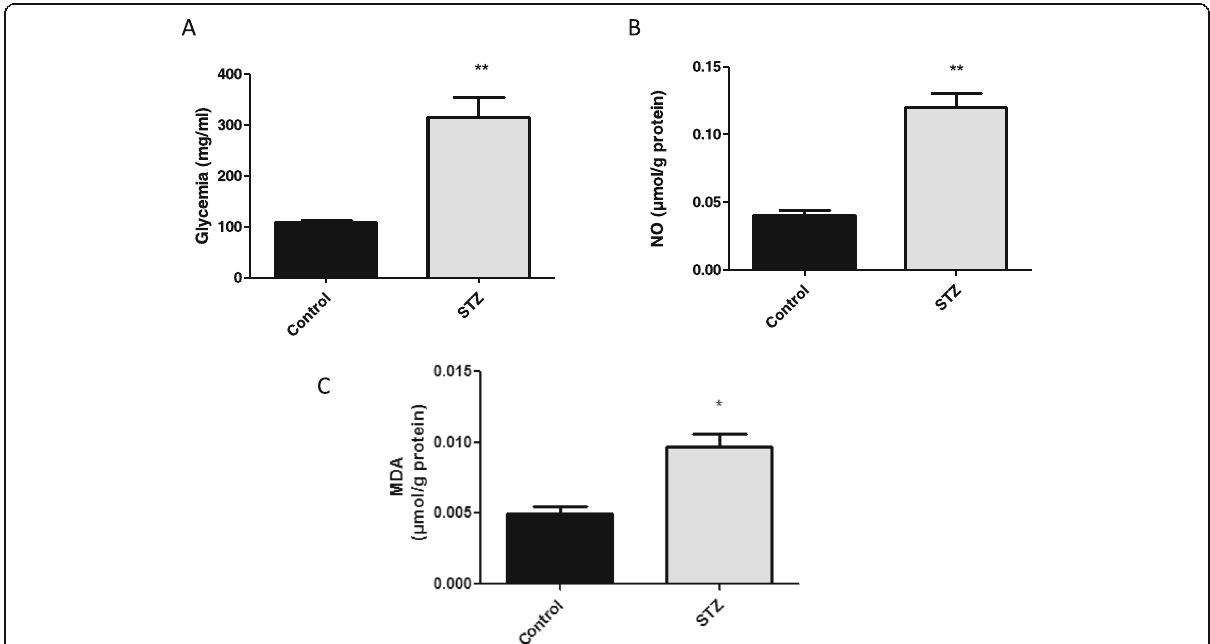
Fig. 2 Effects of streptozotocin upon glycemia ( a ), serum NO ( b ) and serum MDA ( c ). Rats were treated with streptozotocin (STZ) and euthanised on day 10 after treatment. Results represent the Mean ± SEM of values from ten controls and ten STZ-treated animals. * P < 0.05,** P < 0.01 significant differences between control (without any treatment) and STZ-treated animals (Student ’ s t